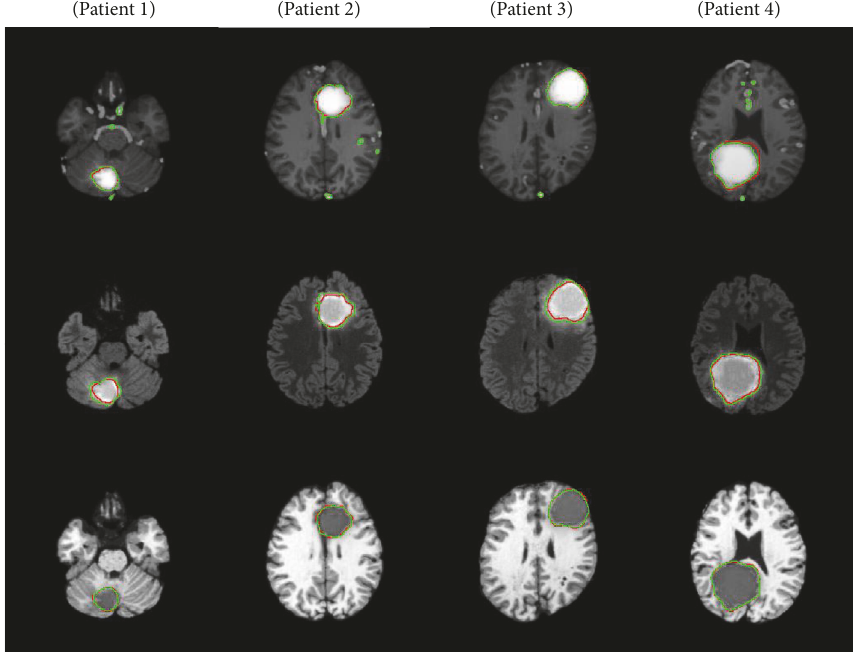
Figure 7: Results of segmentation by level set method in MRI images and the proposed approach. The first and second lines provide the segmentation by level set in T1 contrast and Flair respectively. The last line gives the segmentation using the proposed approach showed in T1. Green: segmentation. Red: ground